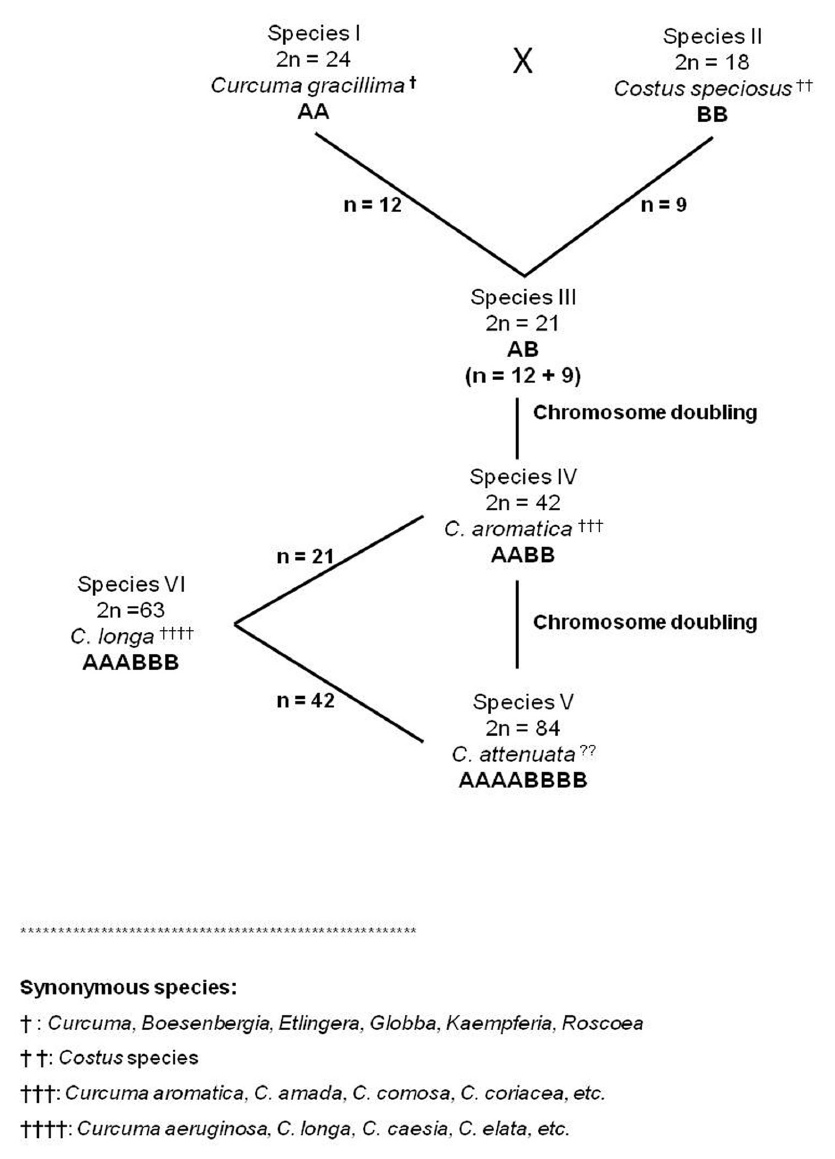
Figure 3. Proposed scheme for Curcuma speciation and